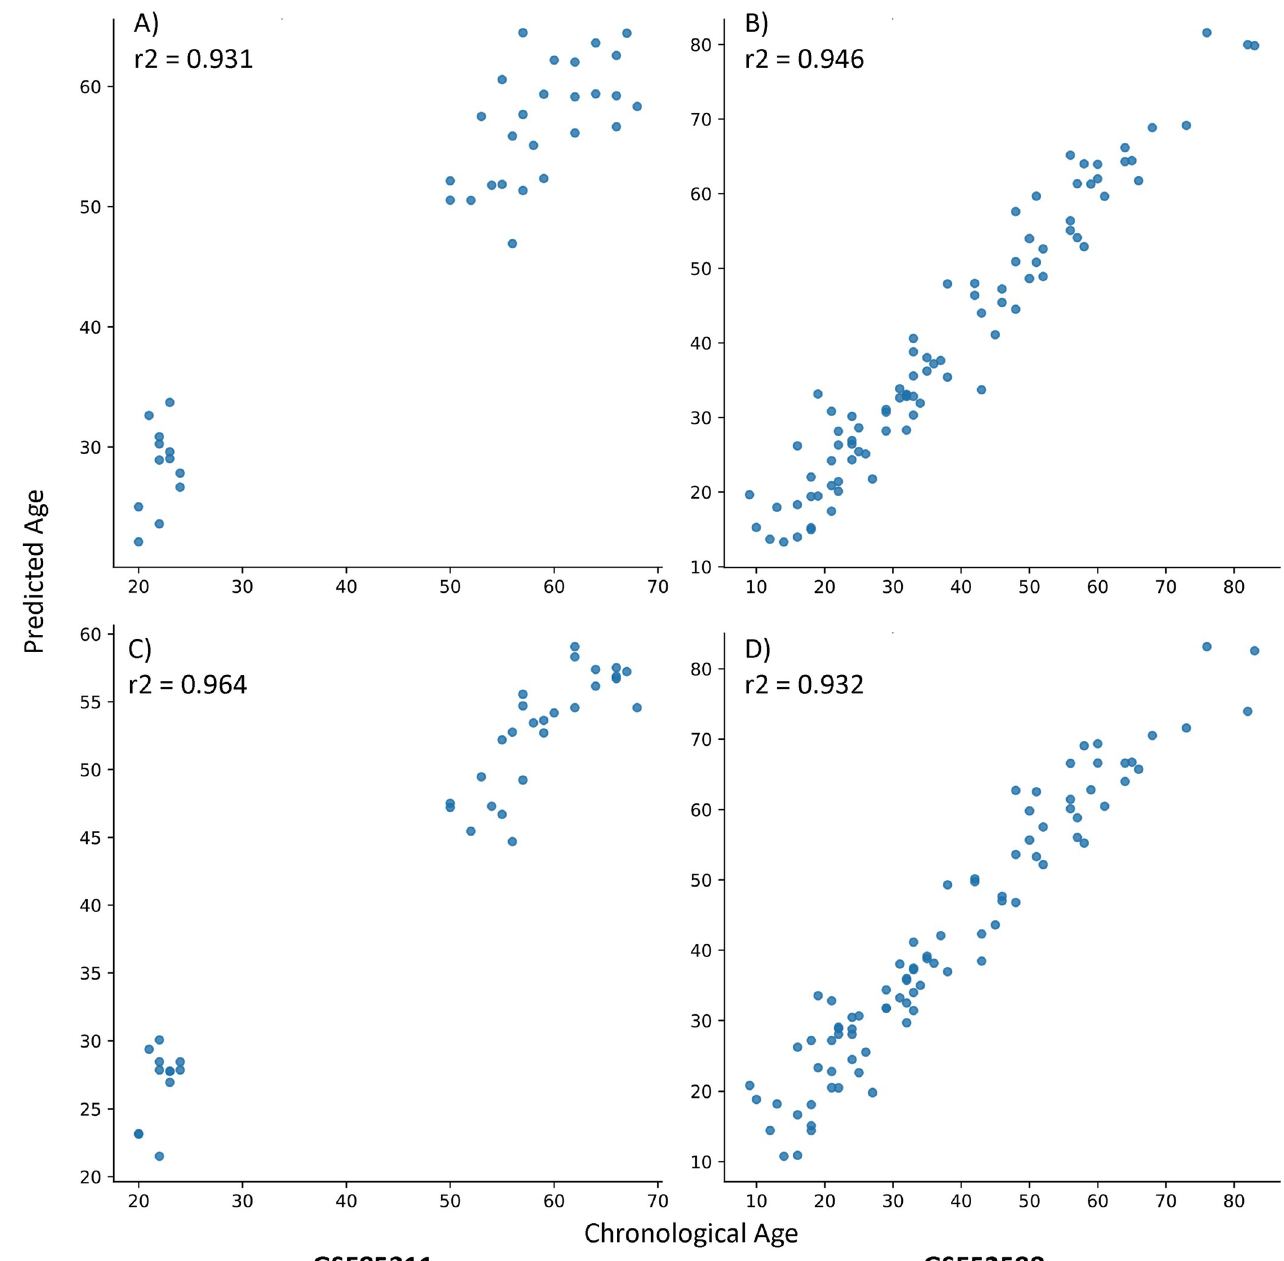
Fig 2. Figure showing the Predicted Ages vs Chronological Ages from our two final models on the two external validation datasets GSE85311 and GSE52588. (A-B) KBest 2000 de novo then Boruta (C-D) Top 5 Most Frequent.